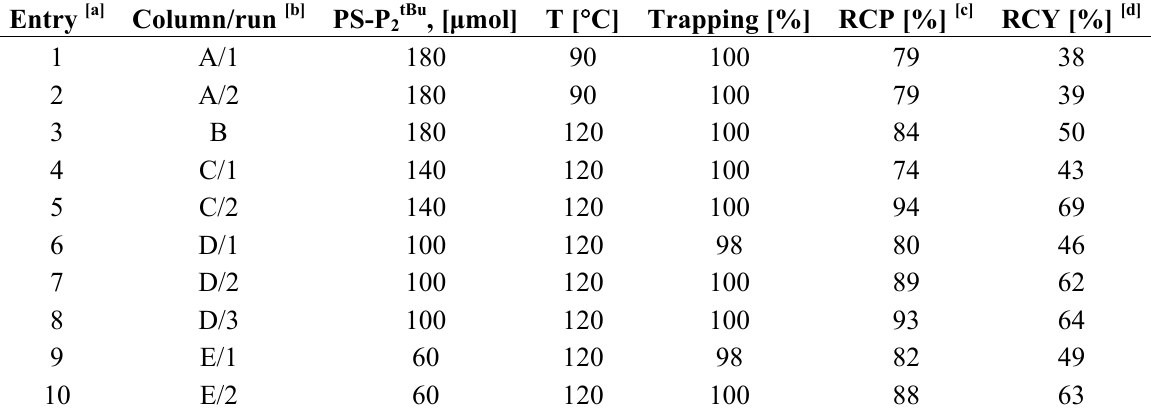
) OMs with PS-P 2tBu : Optimization. 2 2